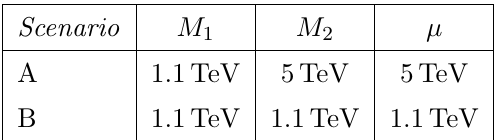
Table 2 . The value of the electroweakino mass parameters assumed in scenarios A and B. on the isolated signals, ruling out the region above and on the right of the horizontal and vertical dashed lines, respectively. This even reaches points close to the origin, where the main decay channel is e t ! t (cid:28)(cid:28) . The main reason is the inclusion of the e mixed